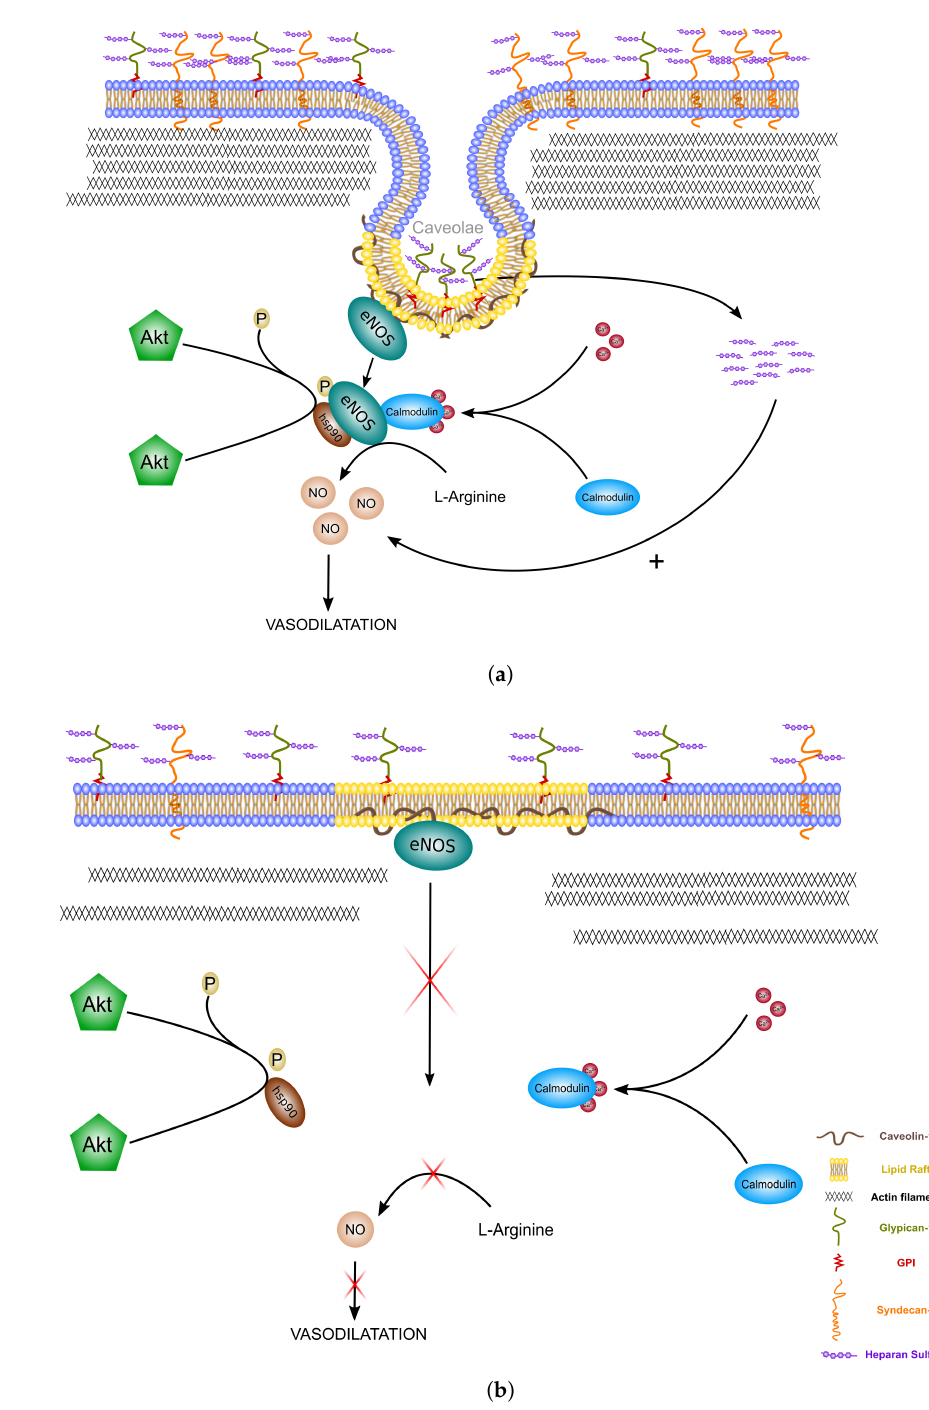
Figure 5. Endothelial glycocalyx-mediated NO production. ( a ) Internalization of the glypican-1 in caveolae is possible thanks to the stabilization of the actin filament by the transmembrane syndecan-1. The heparan sulfate is then cleaved to further increase the production of NO in the cells. This glycocalyx-mediated NO induces a vasodilatation of the endothelium and improves the steatotic graft condition; ( b ) in a graft with higher cold ischemia injury, the lower quantity of syndecan-1 is not sufficient to stabilize the cytoskeleton, which inhibits the formation of caveolae, leading to the absence of NO